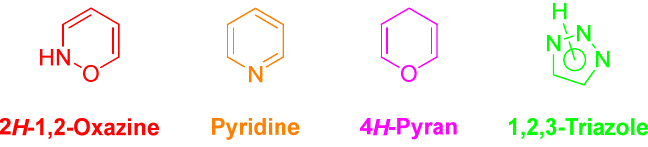
Figure 2. 2 H -1,2-Oxazine, pyridine, 4 H -pyran and 1,2,3-triazole